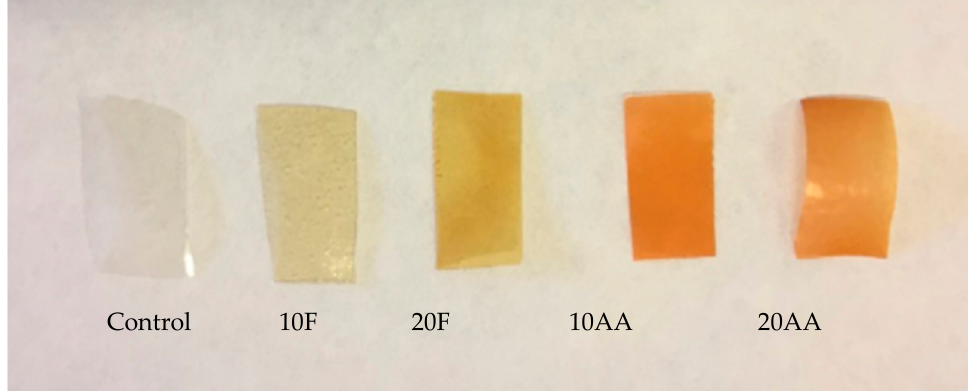
Figure 3. Colour change of fish gelatin films as a function of cross-linker type and content.